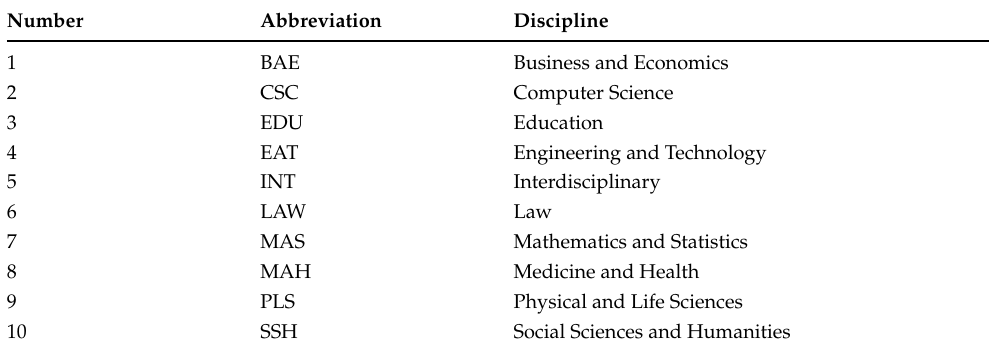
Table A3. The 10 disciplines that the conferences span through.